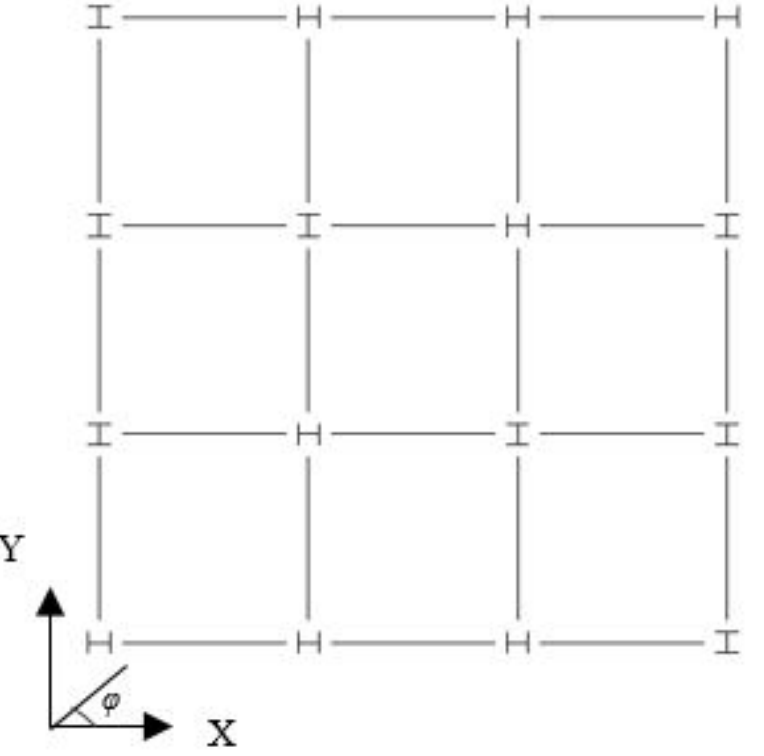
Figure 2. The orientation of the steel columns for the upper story(ies) of the mixed buildings.